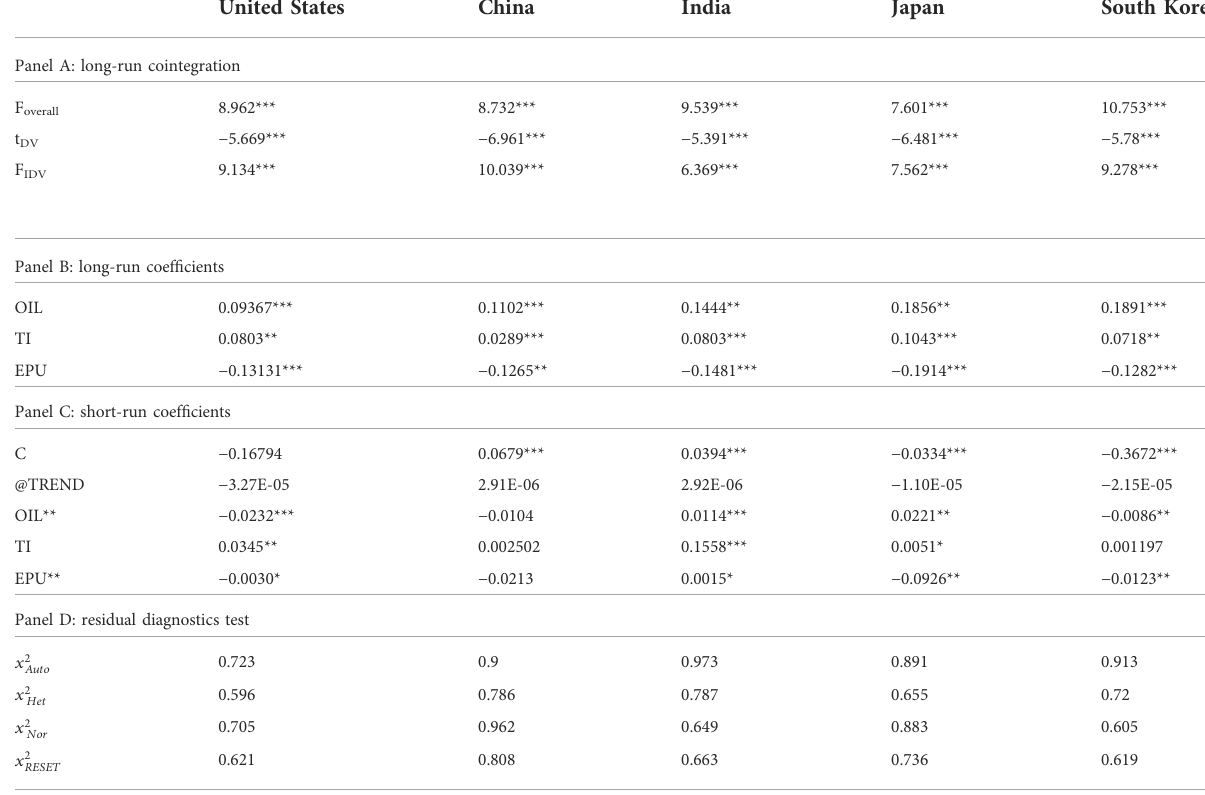
TABLE 5 Long-run and short-run coef fi cients from ARDL